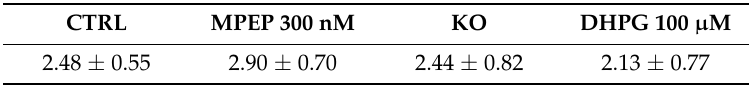
Table 2. ATP measured in liver extracts at the end of 2 h anoxic perfusion (nmol/mg proteins). No significant difference was found among groups (ANOVA).